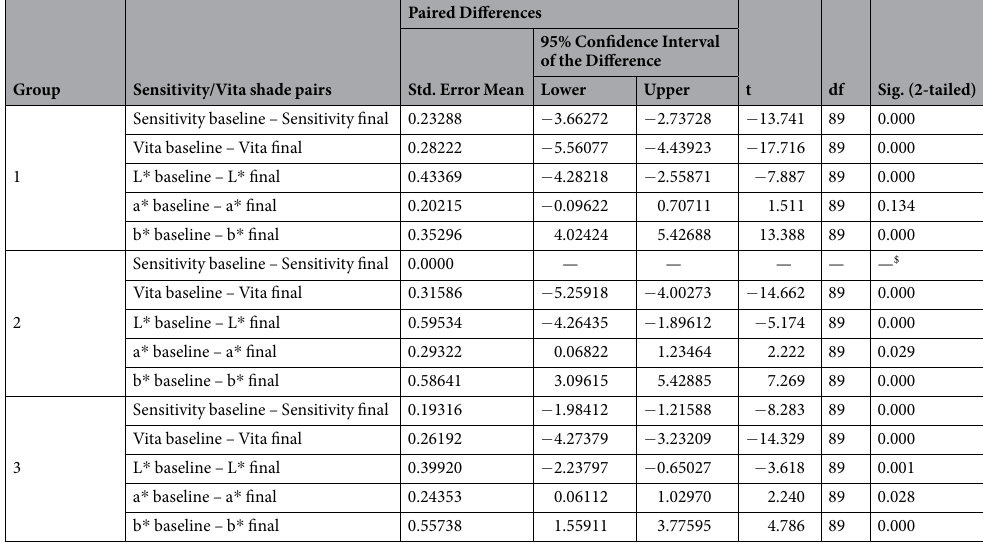
Table 2. Paired samples t -test for within group variations in tooth sensitivity and shade values of teeth at baseline and following bleaching. Group 1 = Teeth bleached with ozone then 38% hydrogen peroxide (n = 90 tooth surfaces in 15 participants). Group 2 = Teeth bleached with 38% hydrogen peroxide then ozone (n = 90 tooth surfaces in 15 participants). Group 3 (control) = Teeth bleached with 38% hydrogen peroxide only (n = 90 tooth surfaces in 15 participants). t = t-test statistics; df = degree of freedom; Sig = Significance (P value). $ Paired difference could not be computed for tooth sensitivity in Group 2 because the standard error of difference equals